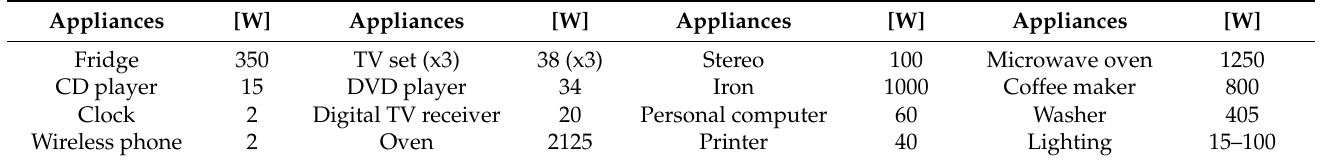
Table 2. List of CREST Demand Model appliances.